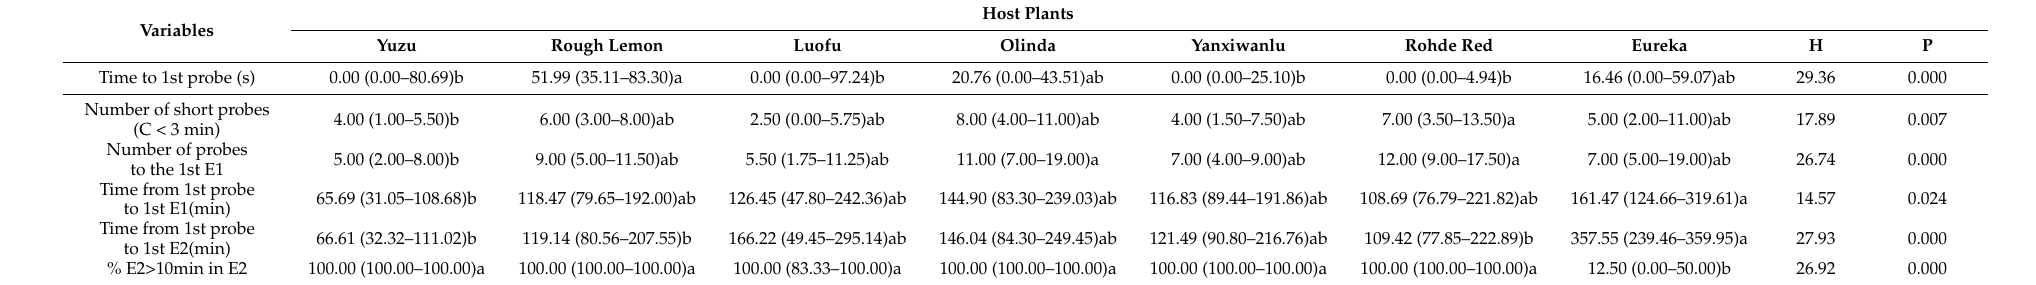
Table 2. Sequential EPG parameters of stylet penetration activities.